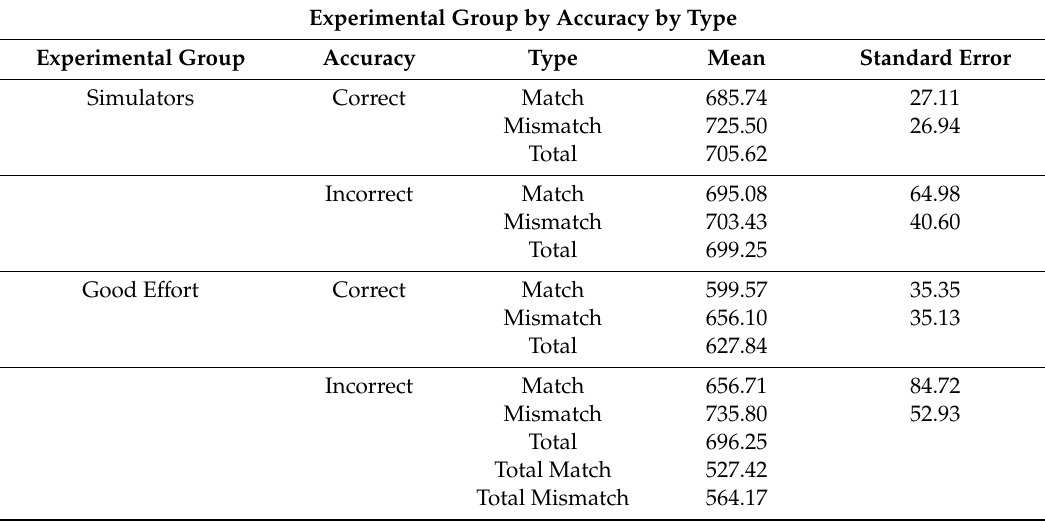
Table 1. The E ff ect of Experimental Group and Stimulus Type on Mean RT in Experiment 1. Experimental Group by Accuracy by